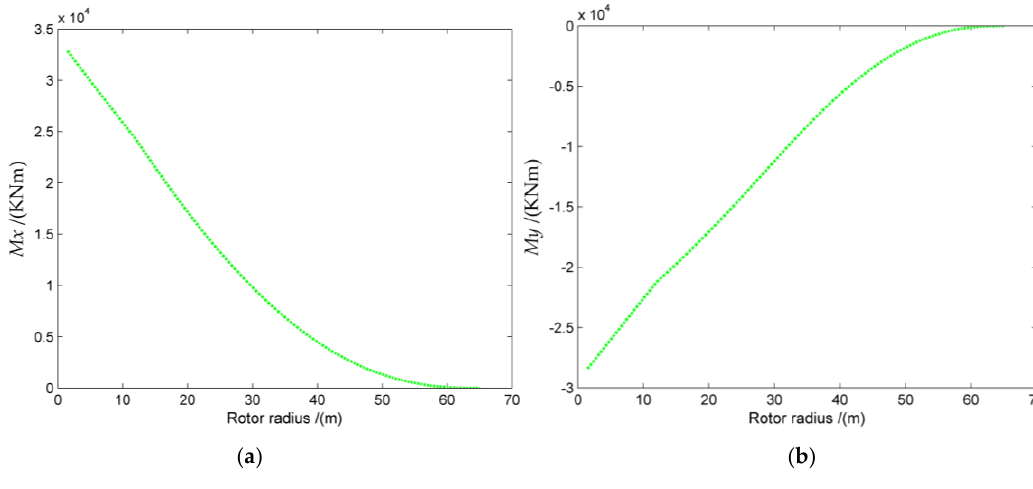
Figure 10. Span-wise distribution of: ( a ) Mx ; and ( b ) My .